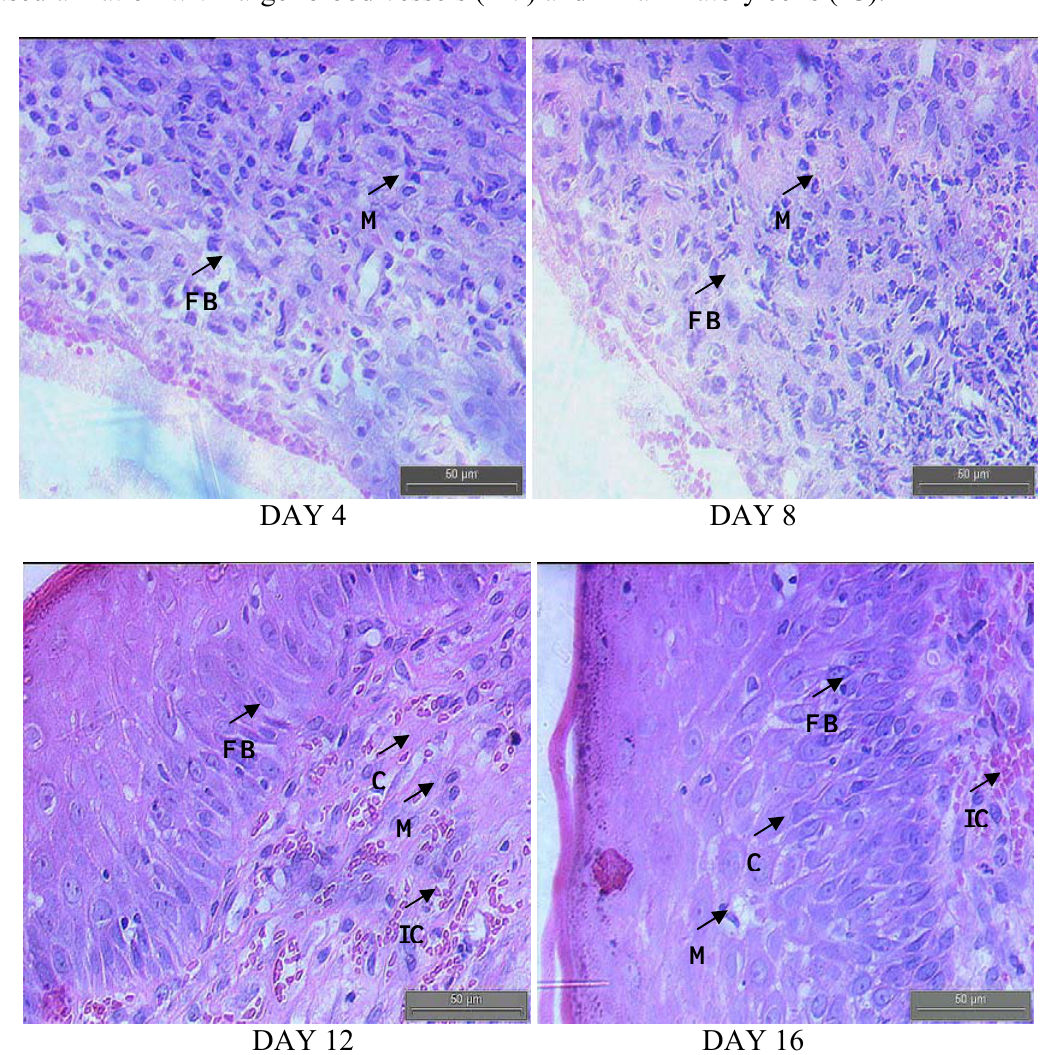
Figure 6. Hematoxylin and eosin stained sections of the granulation tissue in control group at different time intervals. Fibroblasts (FB), macrophages (M), collagen (C) bundles, vascularization with larger blood vessels (BV) and inflammatory cells